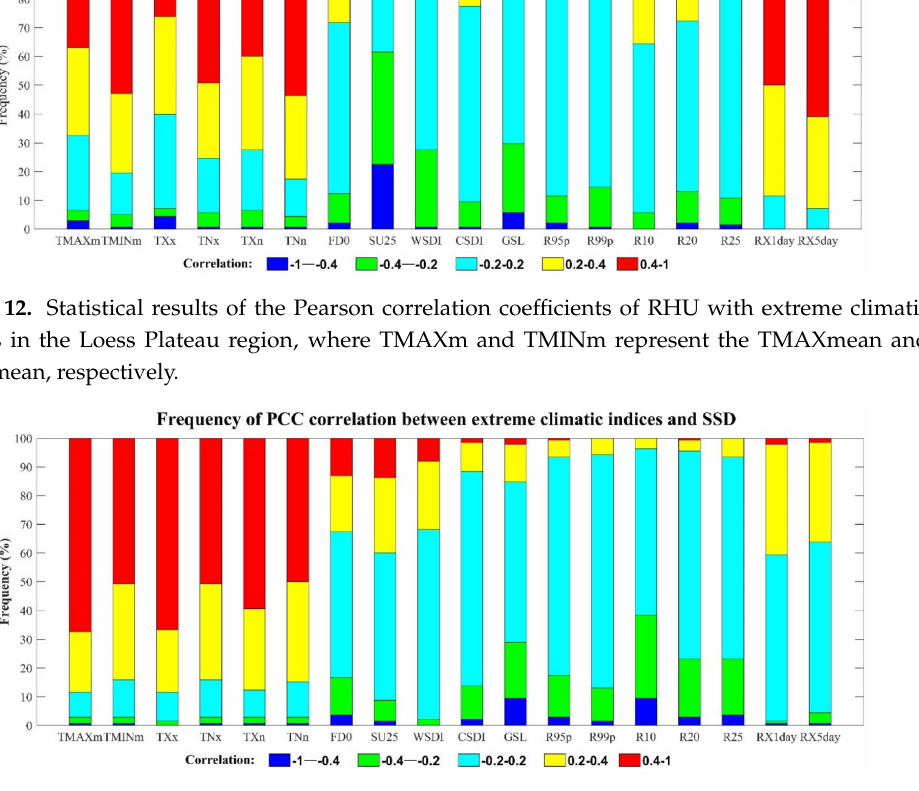
Figure 13. Statistical results of the Pearson correlation coe ffi cients of SSD with extreme climatic indices in the Loess Plateau region, where TMAXm and TMINm represent TMAXmean and TMINmean,